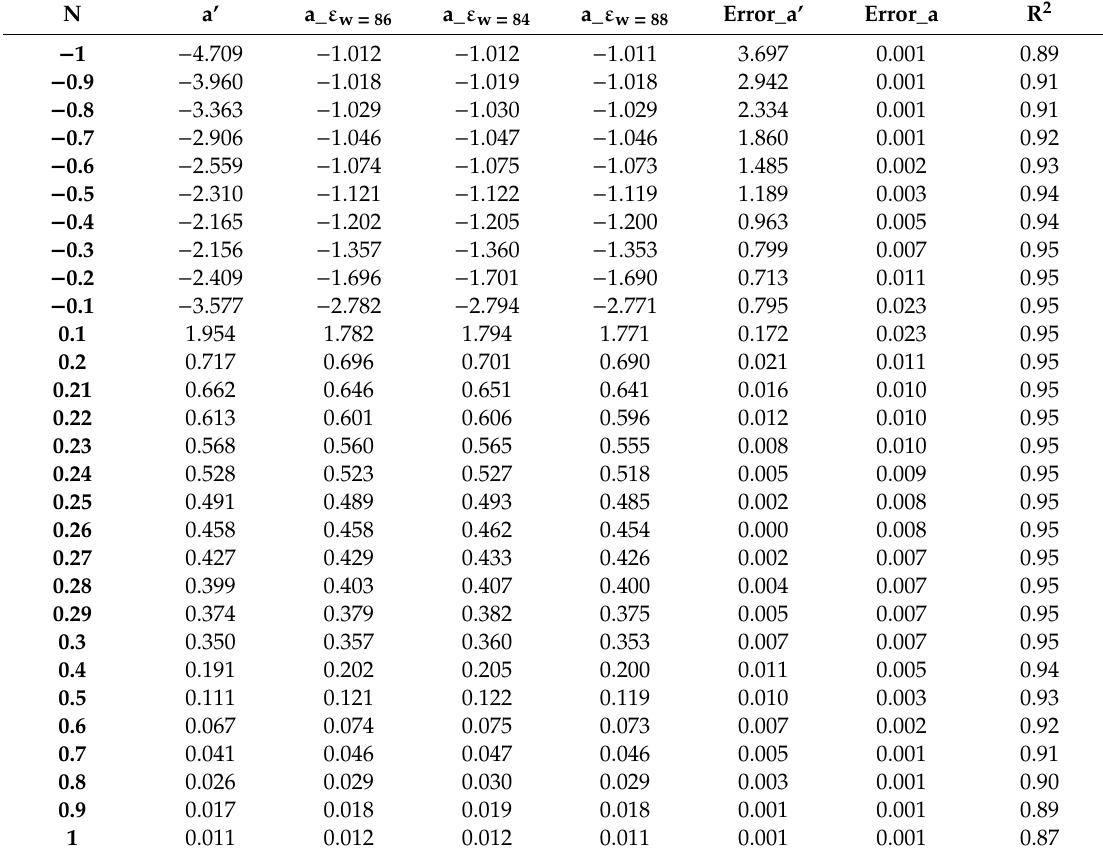
Table 3. Comparison table for determination of parameters a and n in Equation